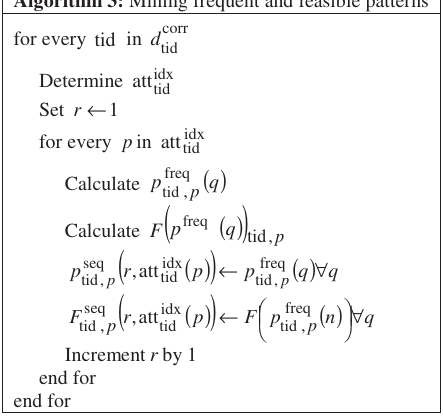
Algorithm 3: Mining frequent and feasible patterns d for every tid in corr tid